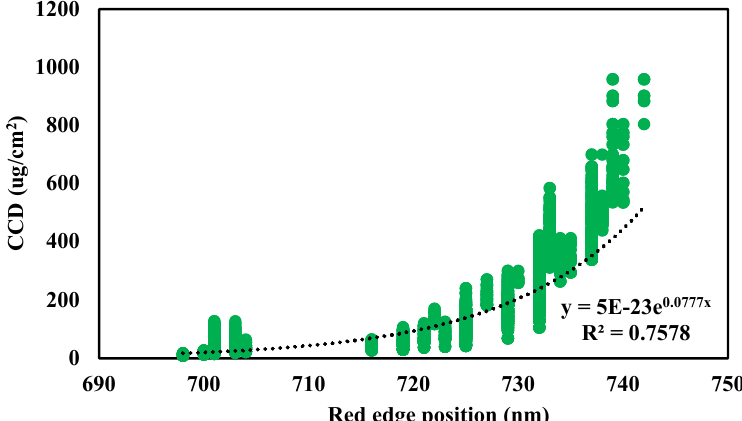
Figure 3. The relationship between the red-edge position and canopy chlorophyll density.